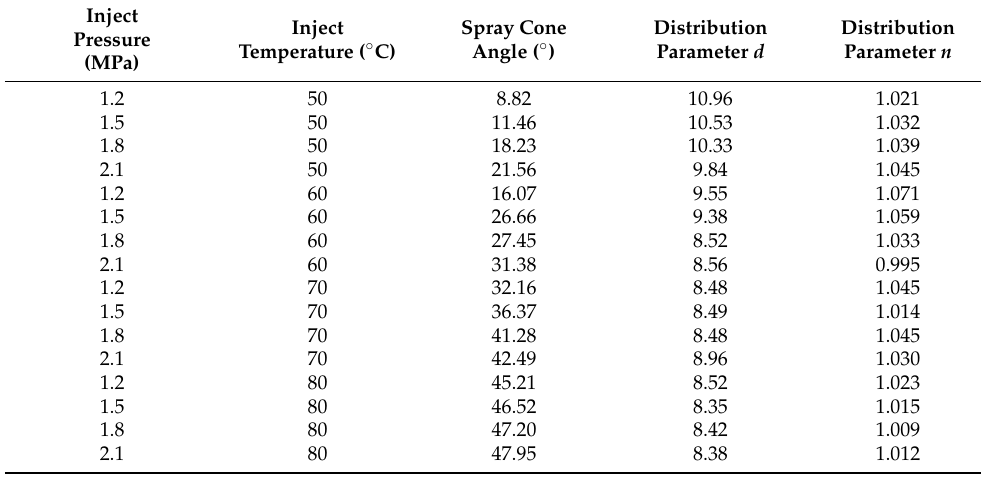
Table 2. Spray cone angles and diameter distribution parameters for injection